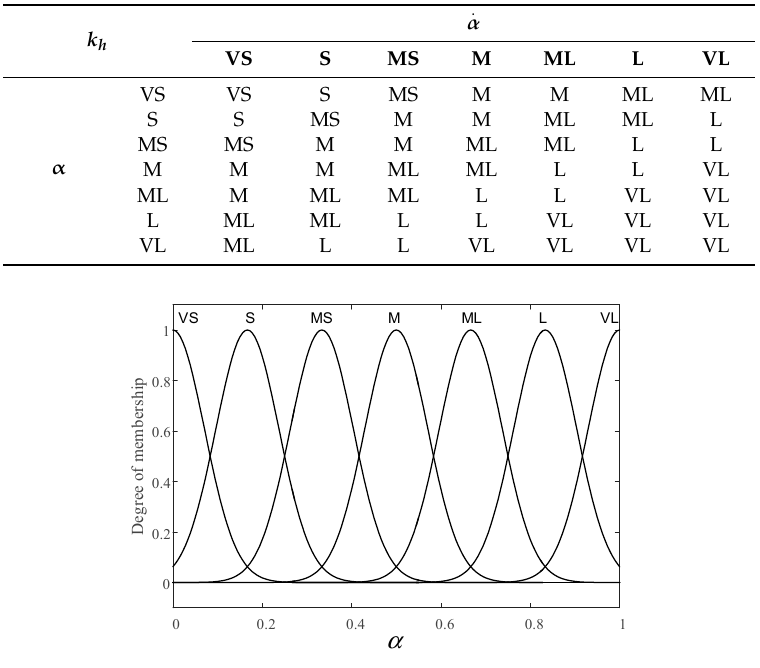
Figure 9. Pedal opening degree membership function.